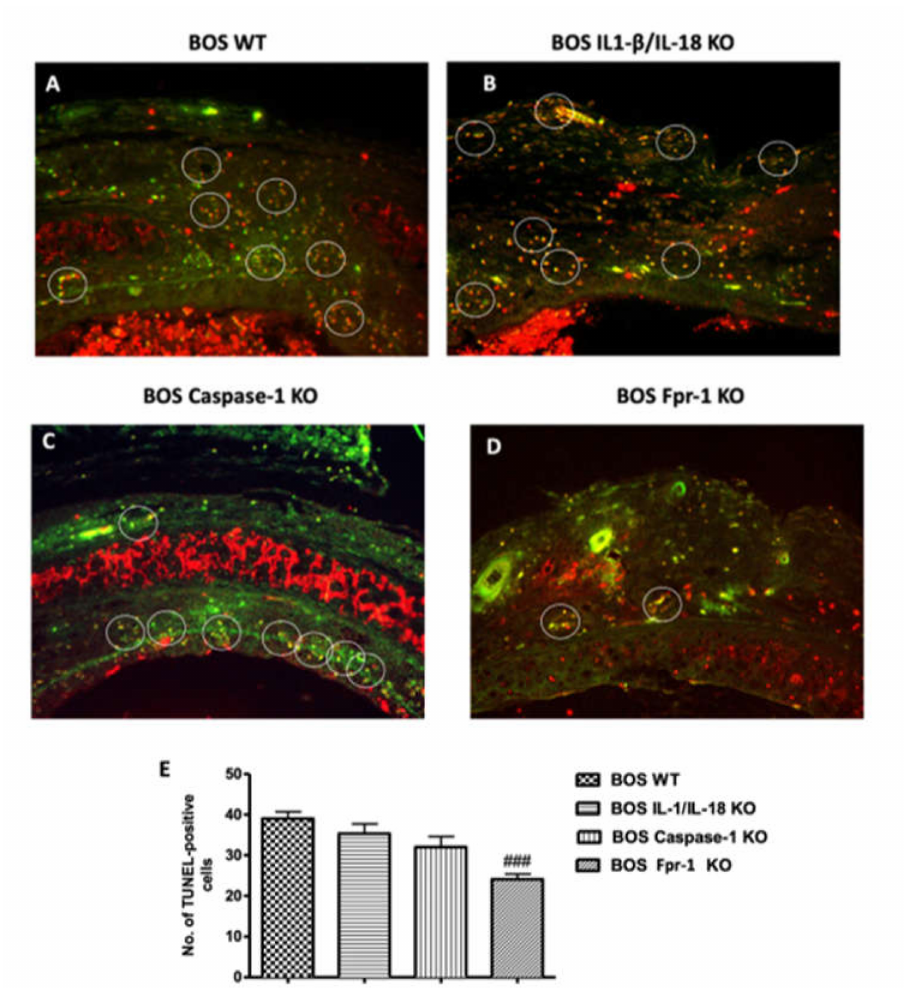
Figure 5. E ff ects of the absence of IL-1 β / IL-18, Casp-1, and Fpr-1 on apoptosis. TUNEL staining of tracheal transplantation: WT ( A ), IL-1 β / IL-18 KO ( B ), Casp-1 KO ( C ), Fpr-1 KO ( D ), graphical quantification ( E ). For TUNEL staining, n = 5 animals from each group were employed. A 20 × magnification is shown (50- µ m scale bar). A p -value less than 0.05 was considered significant. ### p < 0.001 versus the WT